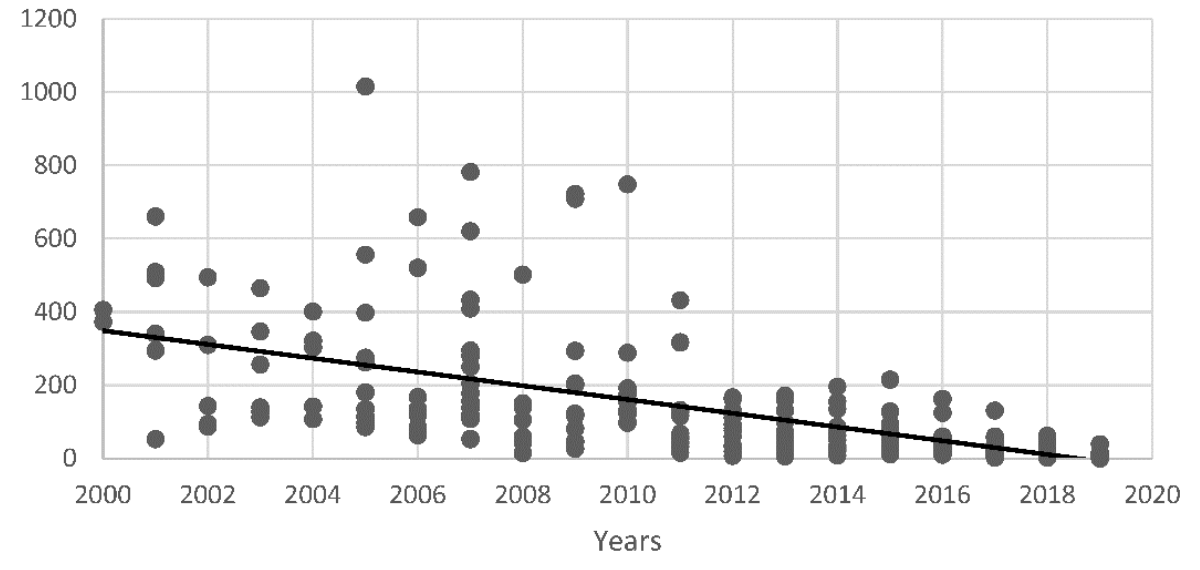
Figure 3. Total number of citations per year.